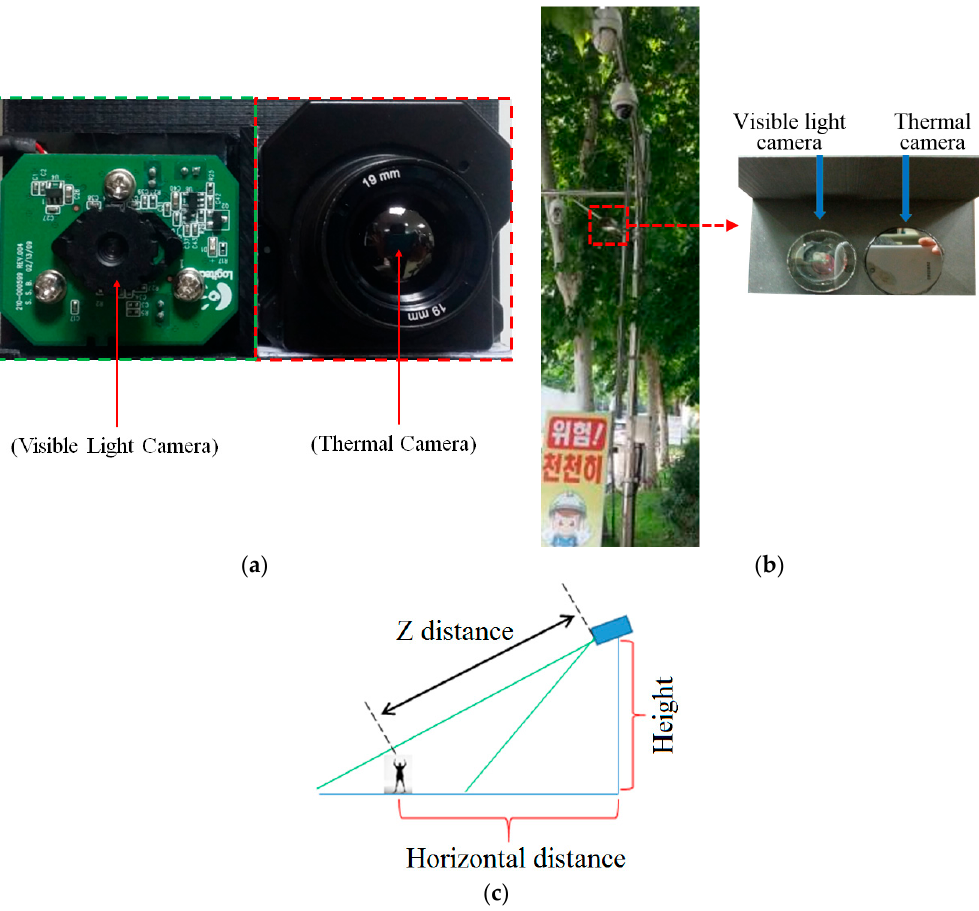
Figure 5. Dual-camera set up that combines visible light and thermal cameras, as used to collect the database in our experiments: ( a ) dual-camera system; ( b ) setup of our camera system in actual surveillance environments; ( c ) distances between camera and user with the height of camera.